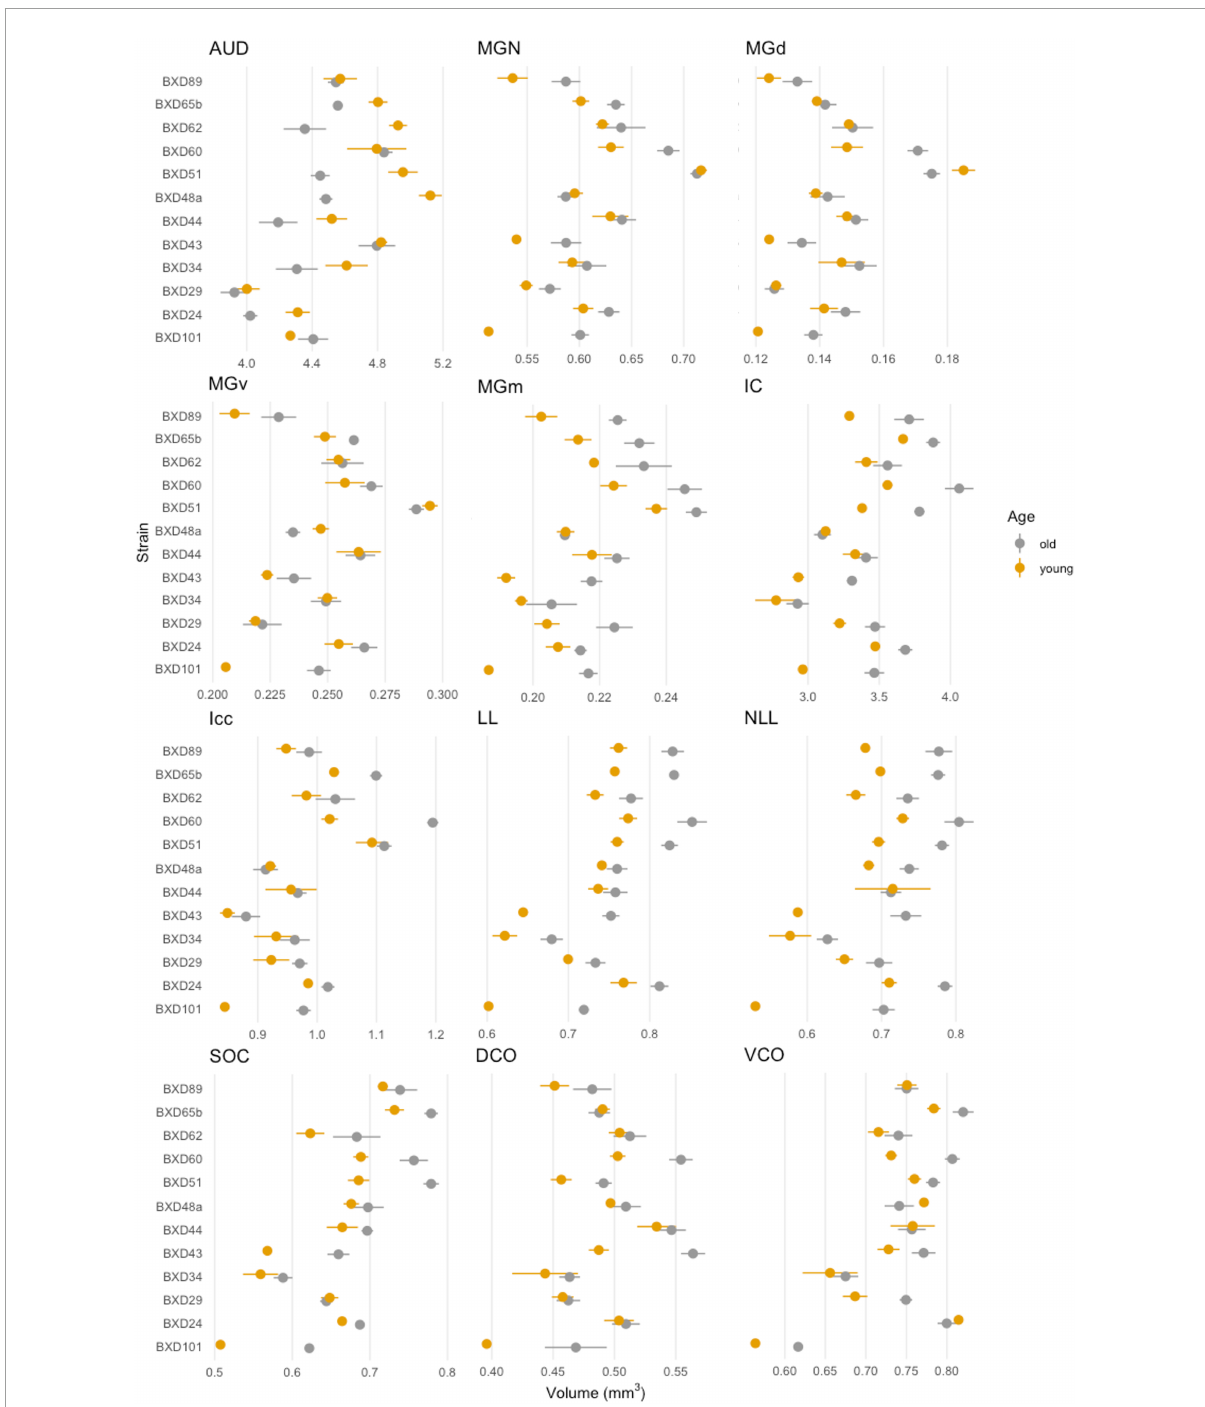
FIGURE2 Summary of individual structure volumes by strain. Mean individual structure volume with horizontal lines indicating standard error in all strains. A variety of strain-based differences in both absolute volume and age-related change is observed in all structures. A range of 4–6 mice were in each age cohort and strain pairing with the exception of BXD101, in which only one mouse was imaged in the young group. AUD, Auditory cortex; MGd, Medial geniculate nucleus, dorsal part; MGv, Medial geniculate nucleus, ventral part; MGm, Medial geniculate nucleus, medial part; MGN, Medial geniculate nucleus; IC, Inferior colliculus; Icc, Inferior colliculus, central nucleus; LL, Lateral lemniscus; NLL, Lateral lemniscus, nucleus; SOC, Superior olivary complex; DCO, Dorsal cochlear nucleus; VCO, Ventral cochlear